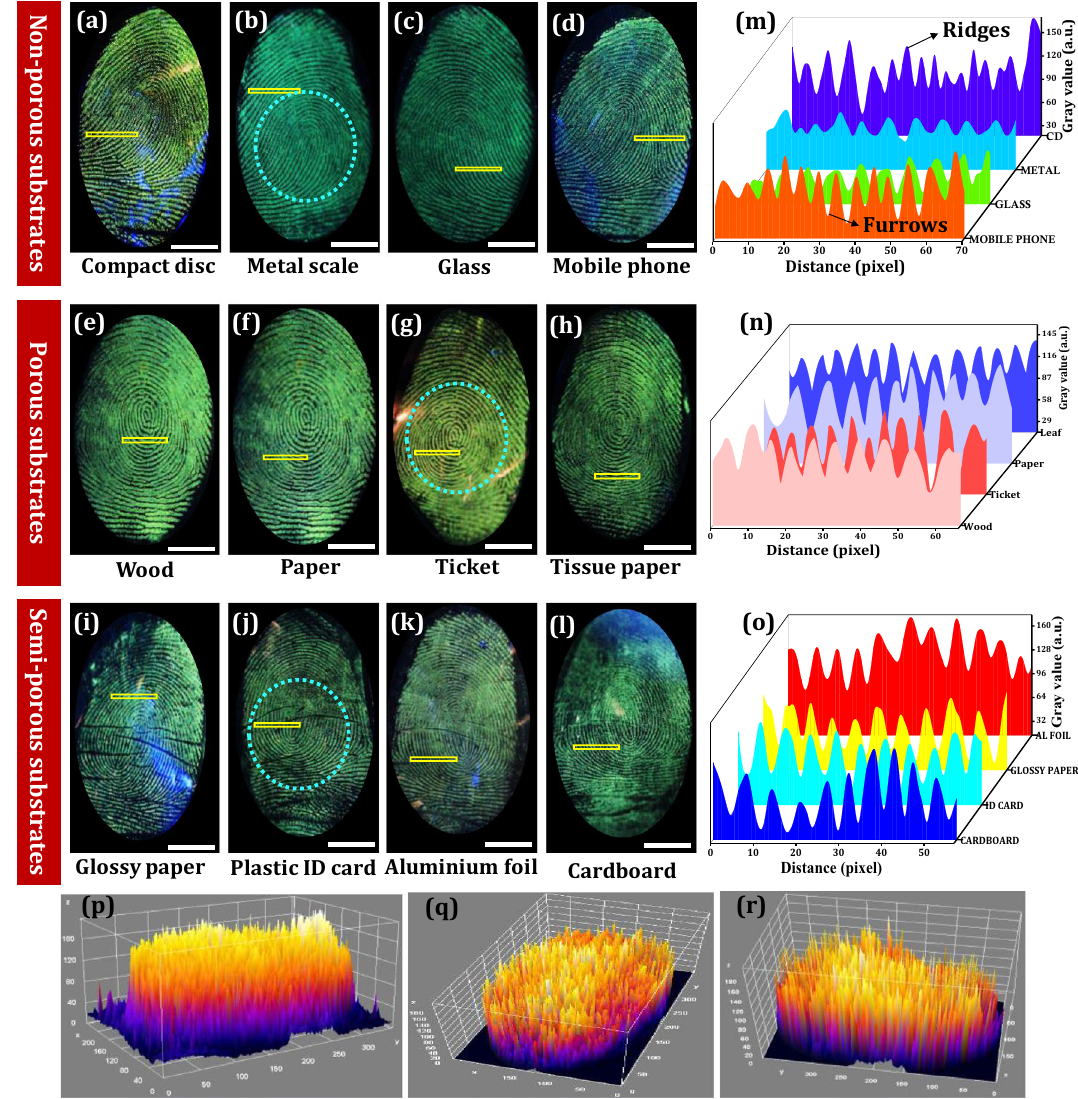
Figure 4. ( a – d ) LFPs visualized using optimized LZOT:NH 4 Cl (4 wt. %) NPs on various non-porous surfaces followed by powder dusting technique; ( e – h ) Developed FPs on various porous surfaces under UV 254 nm light; ( i – l ) RGB images of FPs developed using optimized NPs on the semi-porous surfaces; ( m – o ) Grayscale profiles of marked yellow box on the developed FPs of corresponding row; ( p – r ) 3D interactive plots of the circled portion of the FPs images ( b ), ( g ) and ( j ), respectively (Scale bar: 5 mm). Figures ( p – r ) are generated using ImageJ software 1.8.0_172 (https:// imagej. nih. gov/ ij/ downl oad. html